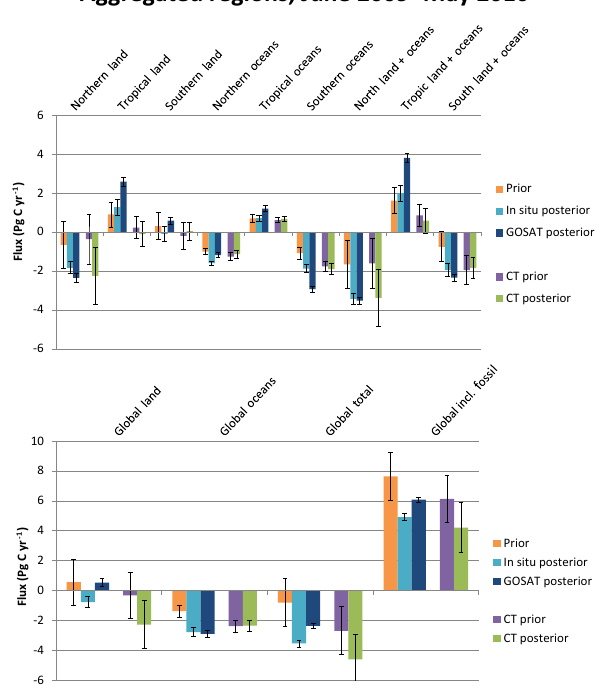
Figure 12. Similar to Fig. 8, except showing results for inversions with tighter prior constraints (with prior uncertainties similar to Car- bonTracker’s). Included are results for the in situ only and GOSAT only inversions. CT2013B results shown in Fig. 8 are repeated here. Error bars represent 1 σ